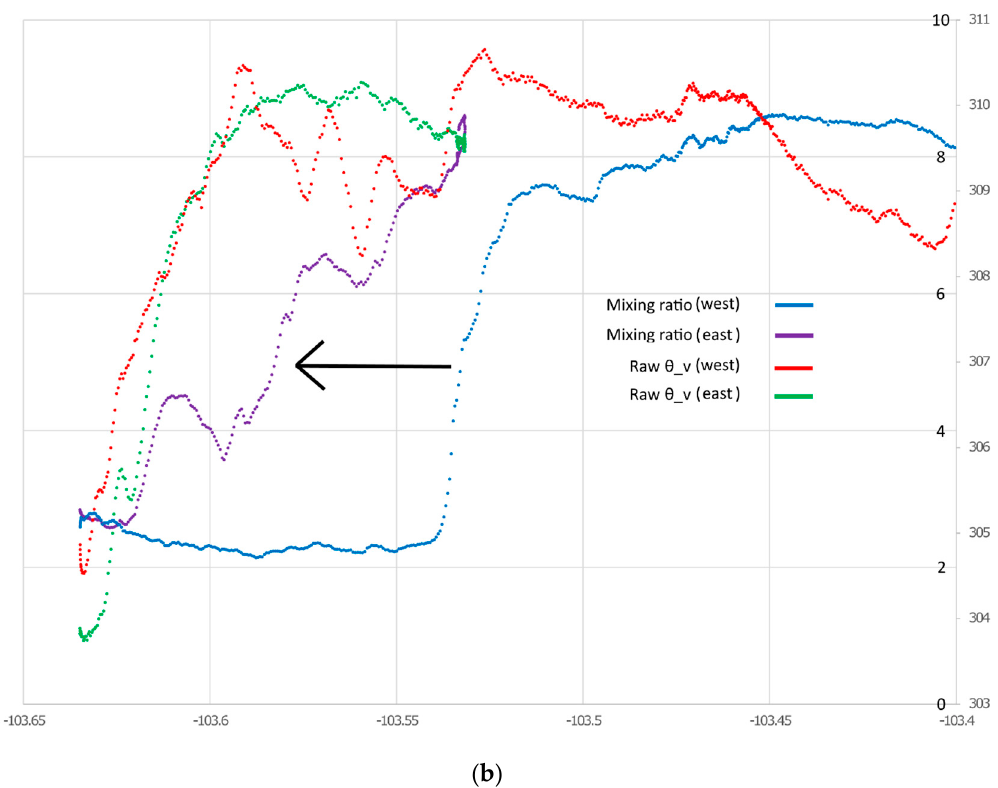
Figure 7. ( a ) Mobile observed mixing ratio (blue; g/kg) and 0300 UTC adjusted 𝜃 𝑣 (red; K) vs. longitude between Comstock and Alpine. Observations from synoptic/mesonet stations used for temporal adjustments are shown by triangles. ( b ) Mixing ratio (g/kg; blue: westbound; purple: eastbound) and 𝜃 𝑣 (unadjusted due to narrow time span; K; red: westbound; green: eastbound) from MMU vs. longitude within about 25 km of Alpine during dryline intercepts. Arrow indicates westward displacement of dryline between westbound and eastbound.